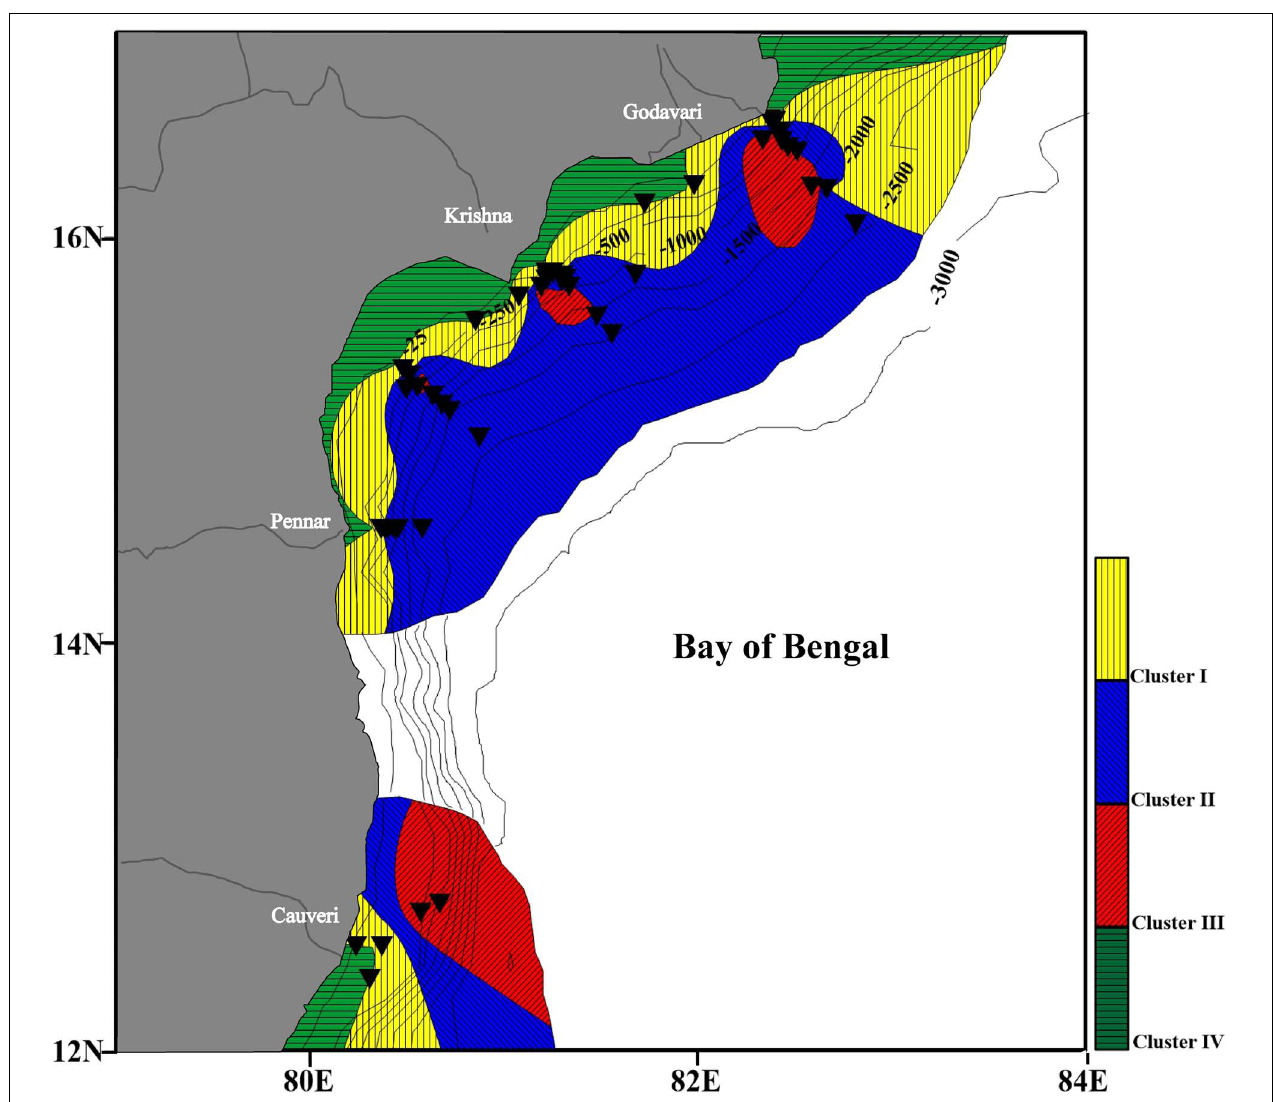
FIGURE 8 | Distribution of the four clusters in the western Bay of Bengal. A clear depth preference of the clusters is evident. Cluster I and II, intermediate water; Cluster III, deep water; and Cluster IV, shallow water. The black triangles represent the sampling